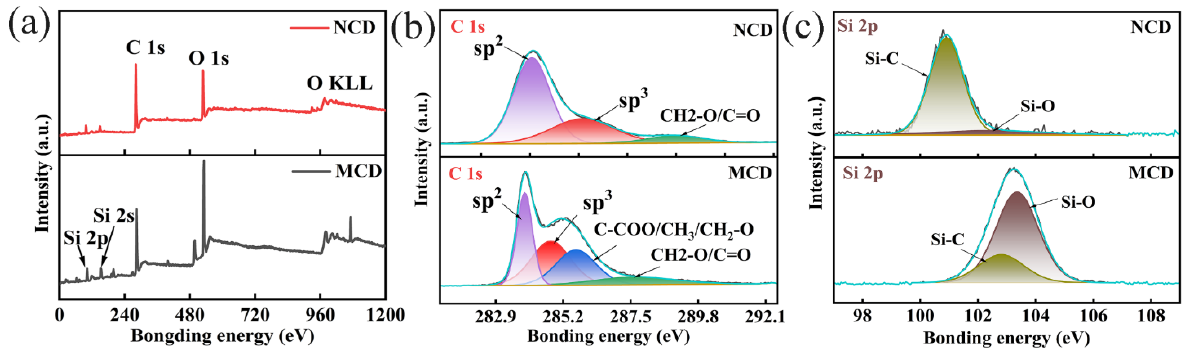
Figure 8. ( a ) The overall distribution of elements of the worn track in the seawater environment; ( b ) The C 1s spectra of the worn track in the seawater environment; ( c ) The Si 2p spectra of the worn track in the seawater environment.